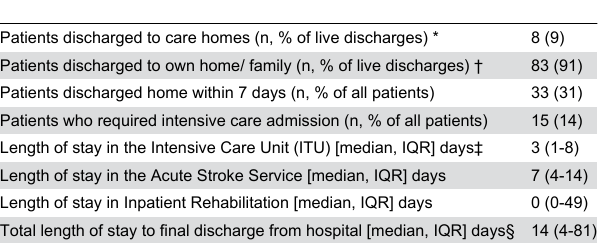
Table 4. Data relating to service provision.